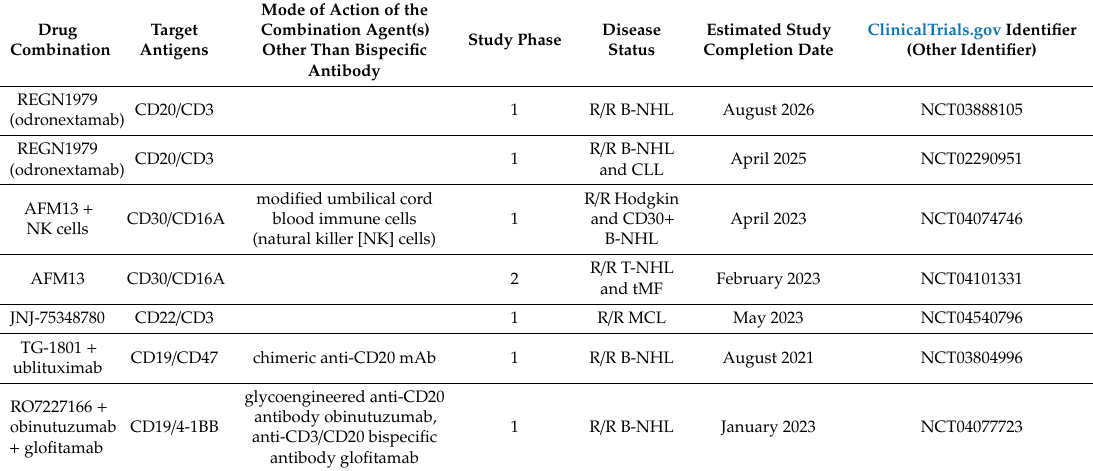
Table 4. Selected clinical trials that incorporate bispecific antibodies in experimental therapy of